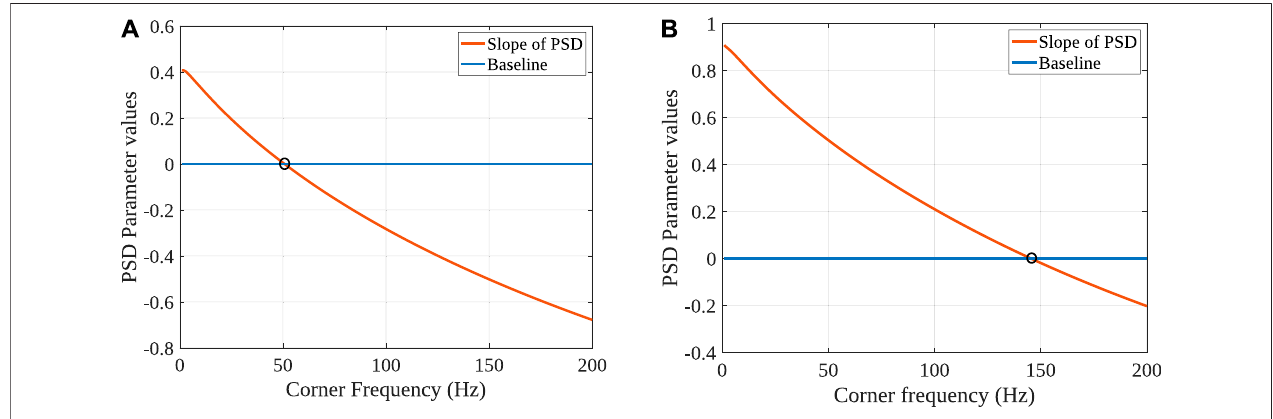
FIGURE 7 | Slope of the power spectrum for time series ξ ( t ) for various trial corner frequencies. The parameter at which after baseline correction the PSD parameter matches the zero baseline gives the corner frequency in our system. Again, Figures (A) and (B) are for two different laser powers, 14 and 54 mW, that is two different trap stiffnesses.